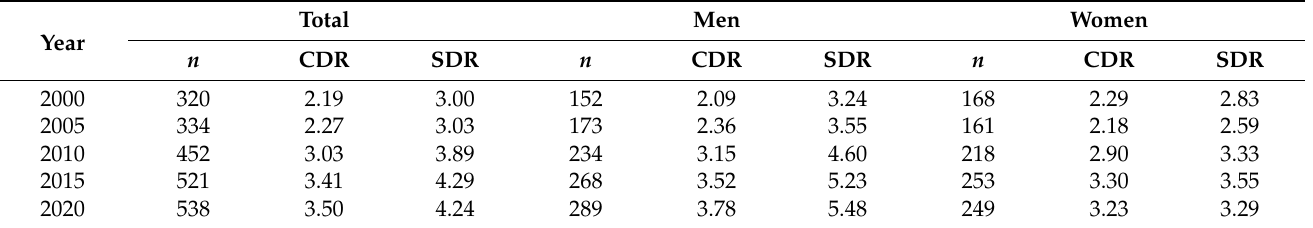
Table 4. Number of deaths, CDR per 100,000 and SDR per 100,000 due to skin melanoma of rural residents in Poland by gender, 2000, 2005, 2010, 2015 and 2020.